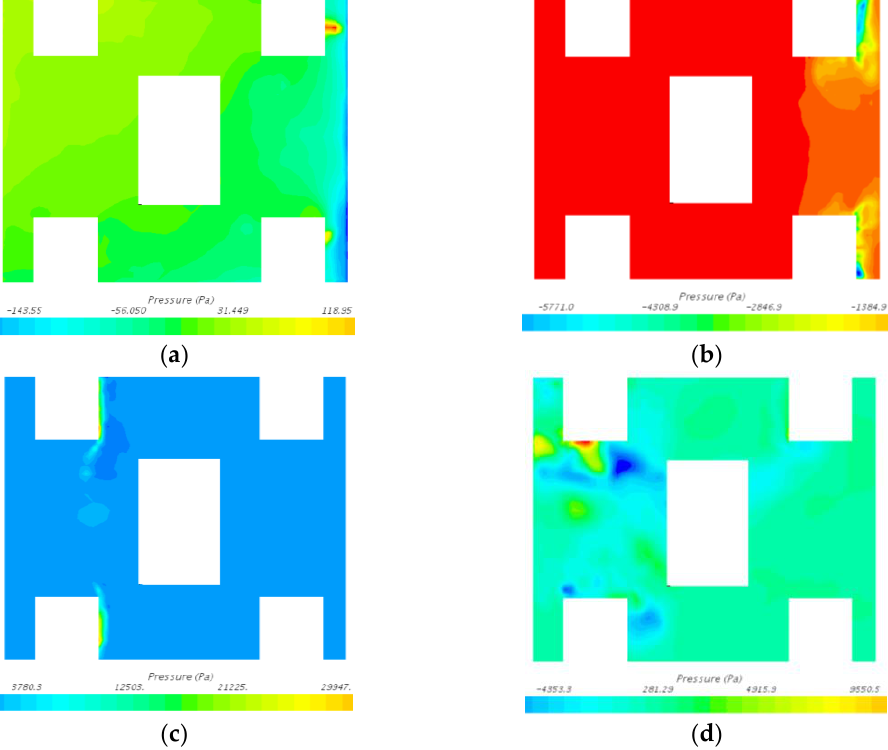
Figure 19. Slamming pressure distribution of deck in head sea wave condition. ( a ) t 1 = 175.795 s. ( b ) t 2 = 176.575 s. ( c ) t 3 = 180.615 s. ( d ) t 4 = 184.08 s.